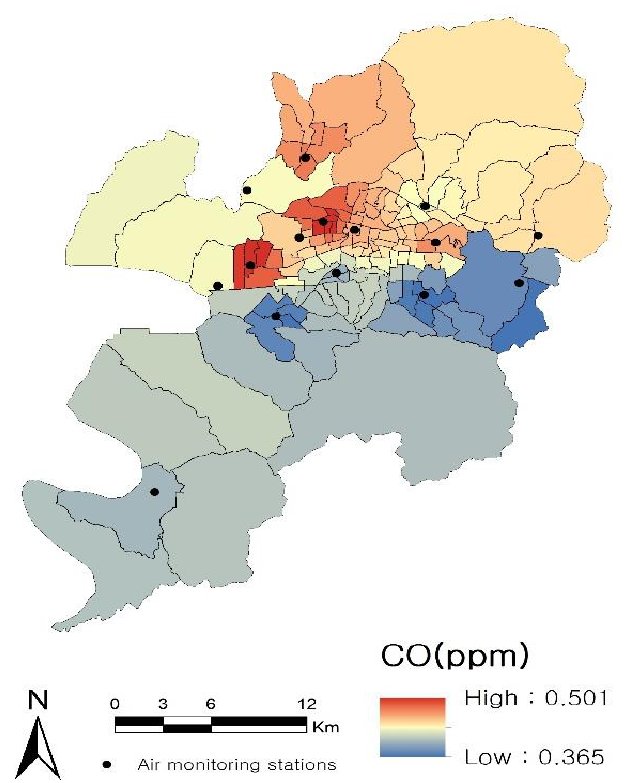
Figure 5. Spatial distribution of CO.